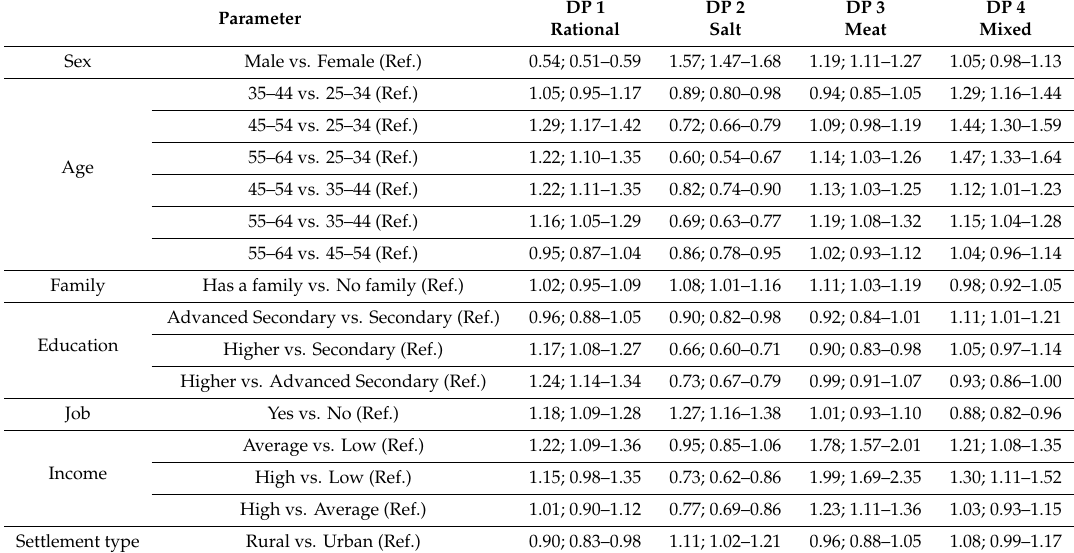
Table 5. Multivariate association of socioeconomic and demographic variables with the dietary